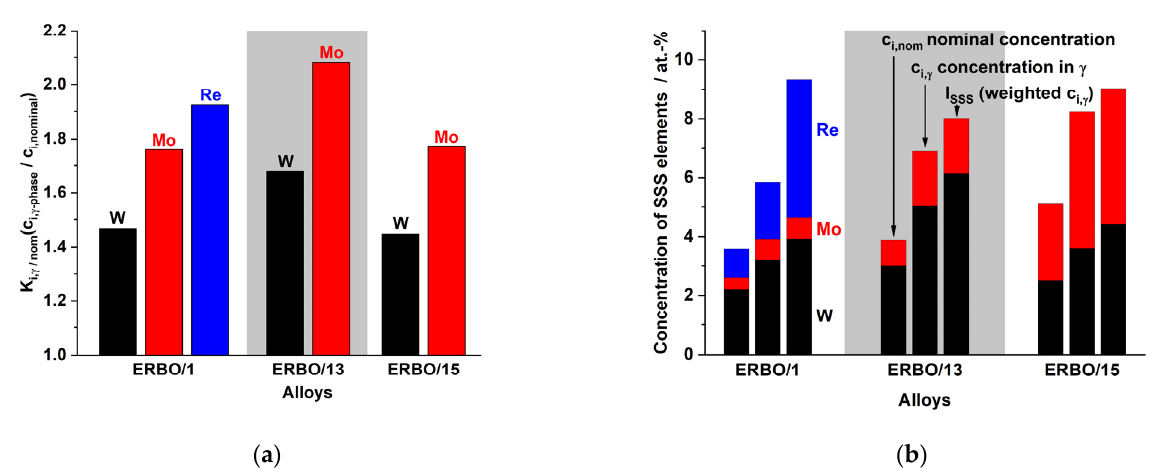
Figure 9: Analysis of the EPMA measured partitioning behavior of solid solution strengthening elements in the single- crystalline reference alloys: ( a ) partitioning efficiency; ( b ) comparison of the absolute concentration values of solid solution strengtheners regarding their nominal concentration c i ,nom (left column), resulting γ -matrix phase concentration c i , γ (middle column) and evaluation of general solid solution strengthening effectivity against creep (weighted c i , γ , see I SSS in Equation (3)).